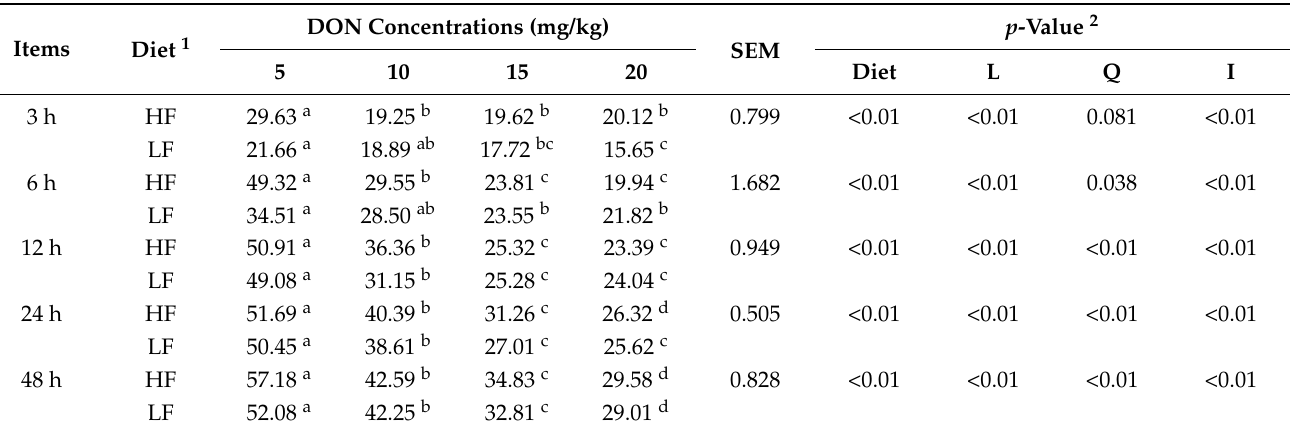
Table 3. Effect of DON and substrate levels on ratio of DON degradability (%) in in vitro